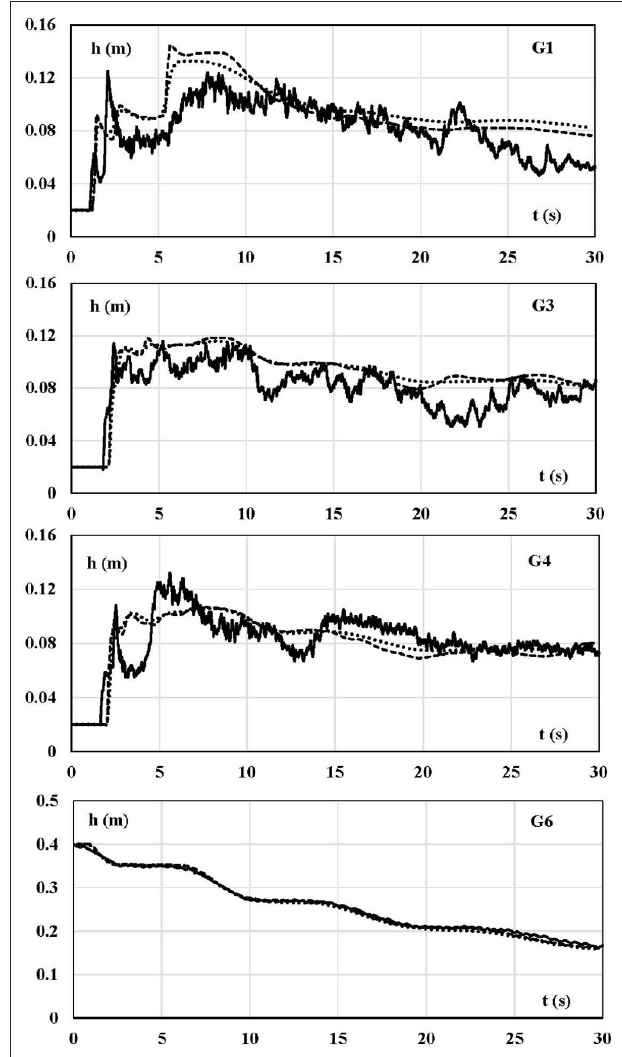
FIGURE 4 | Test case II. Experimental and numerical free surface time histories. Solid line: experimental measurements from Soares-Frazão and Zech (2007) . Dotted line: DBE numerical results obtained with the coarse grid. Dashed line: DBE numerical results obtained with the fine